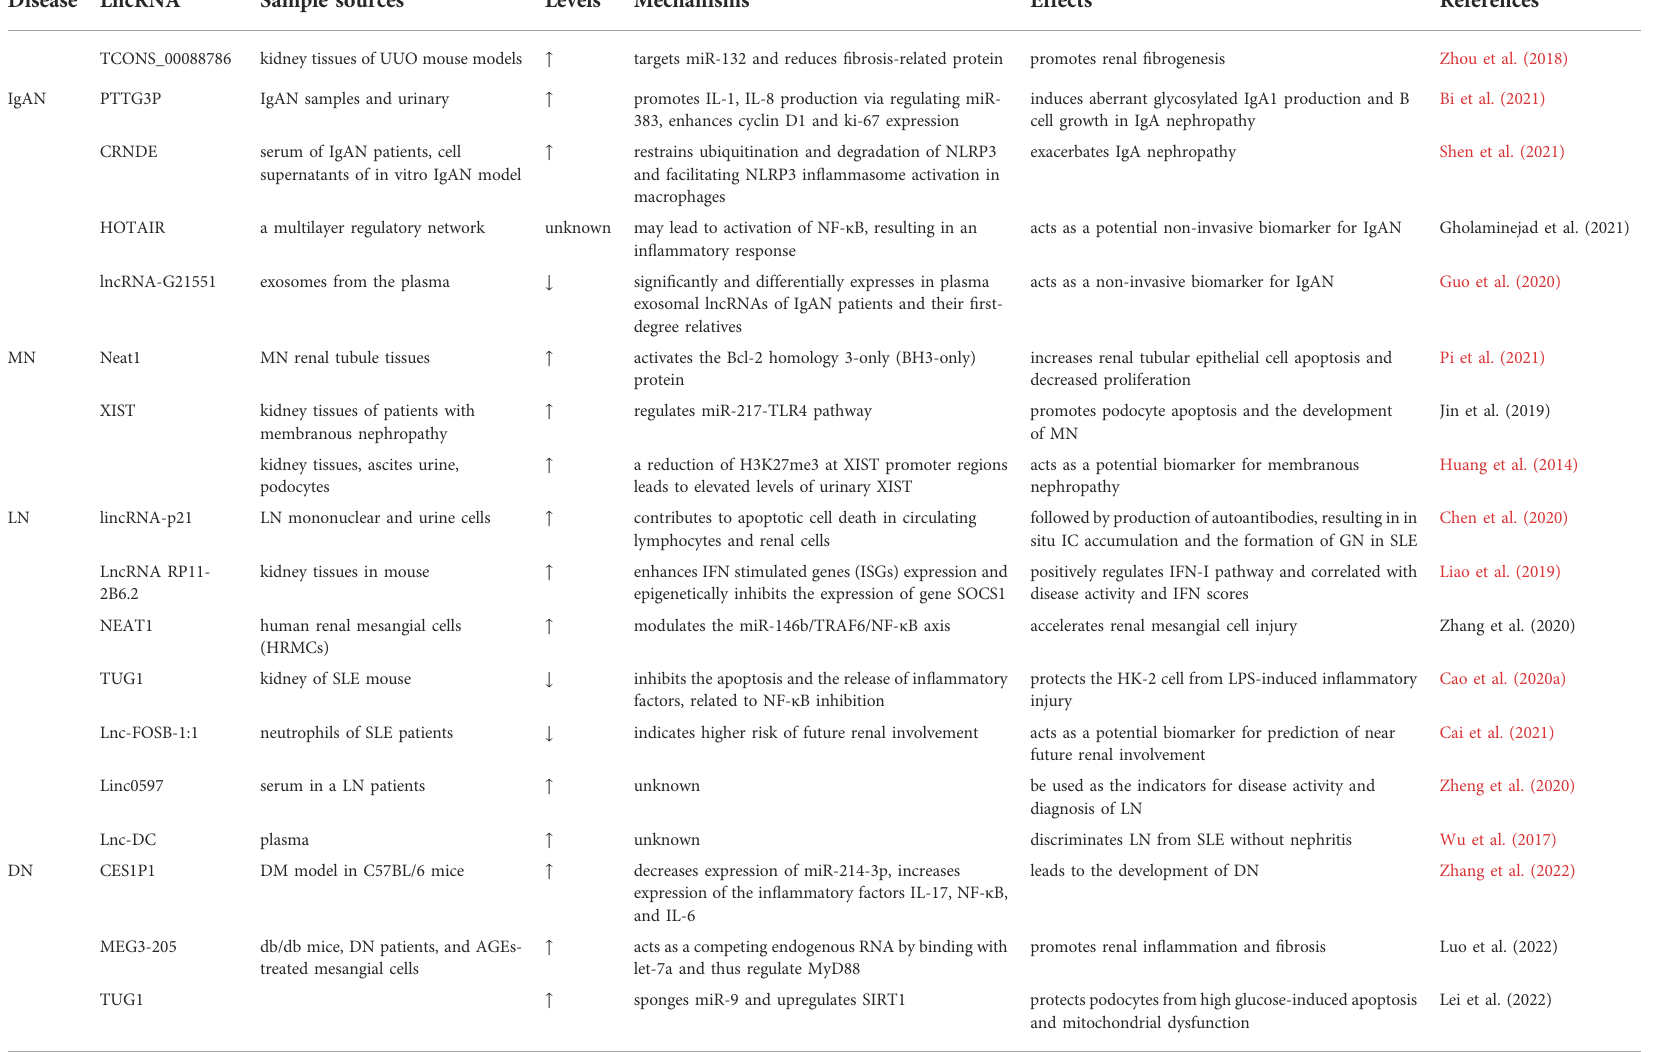
TABLE 1 ( Continued ) Levels, effects and functions of lncRNAs in experiments in kidney